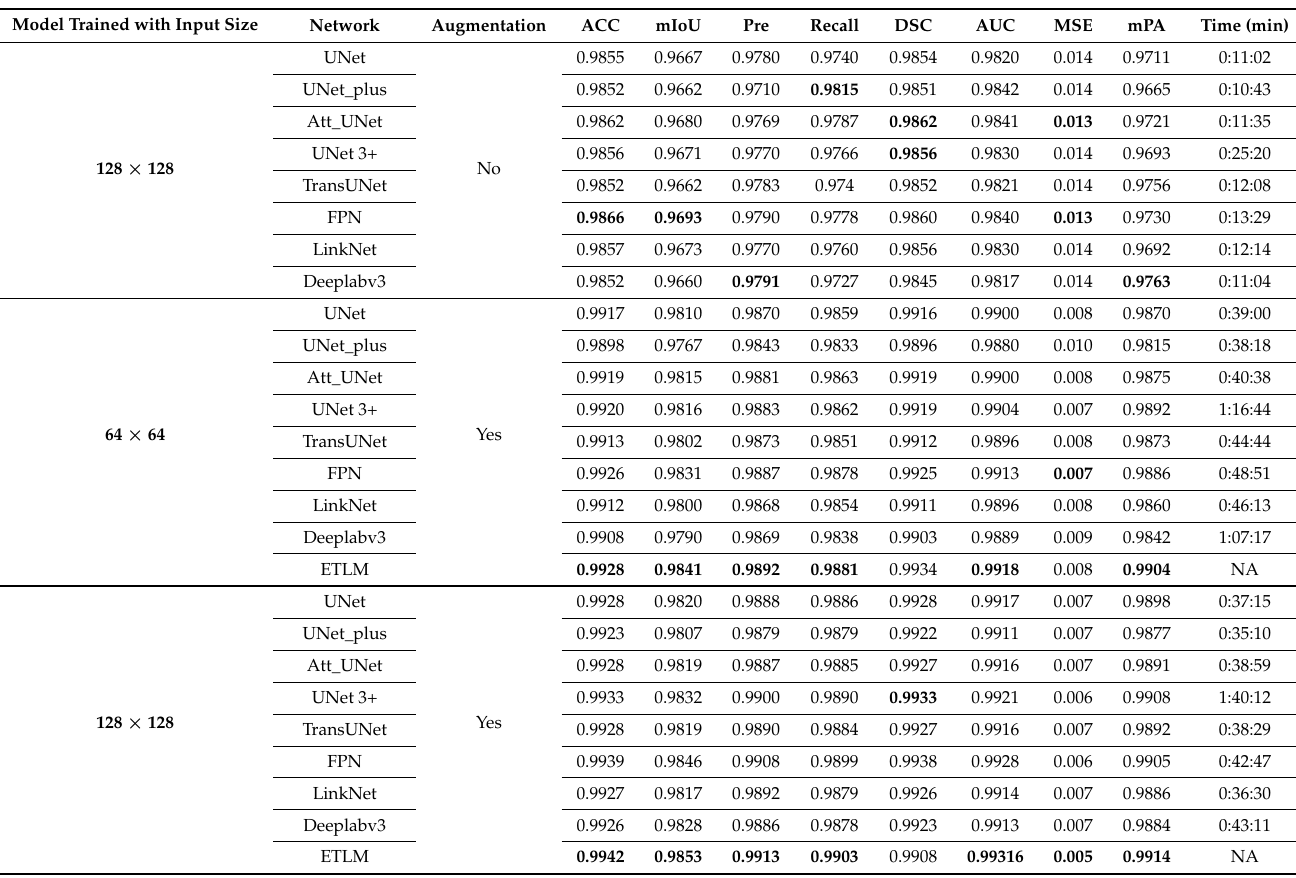
Table 7. Level one: performance evaluation and comparison of segmentation results for all models with various input sizes, and with and without